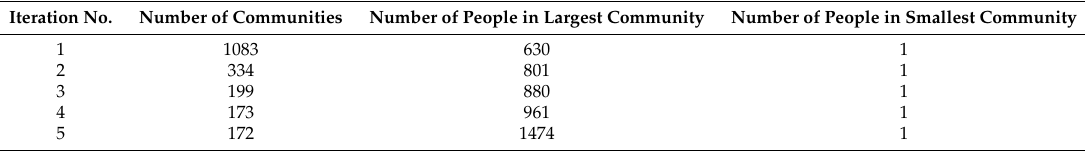
Table 3. Results of discovering communities for all students via the Louvain algorithm. Iteration No.